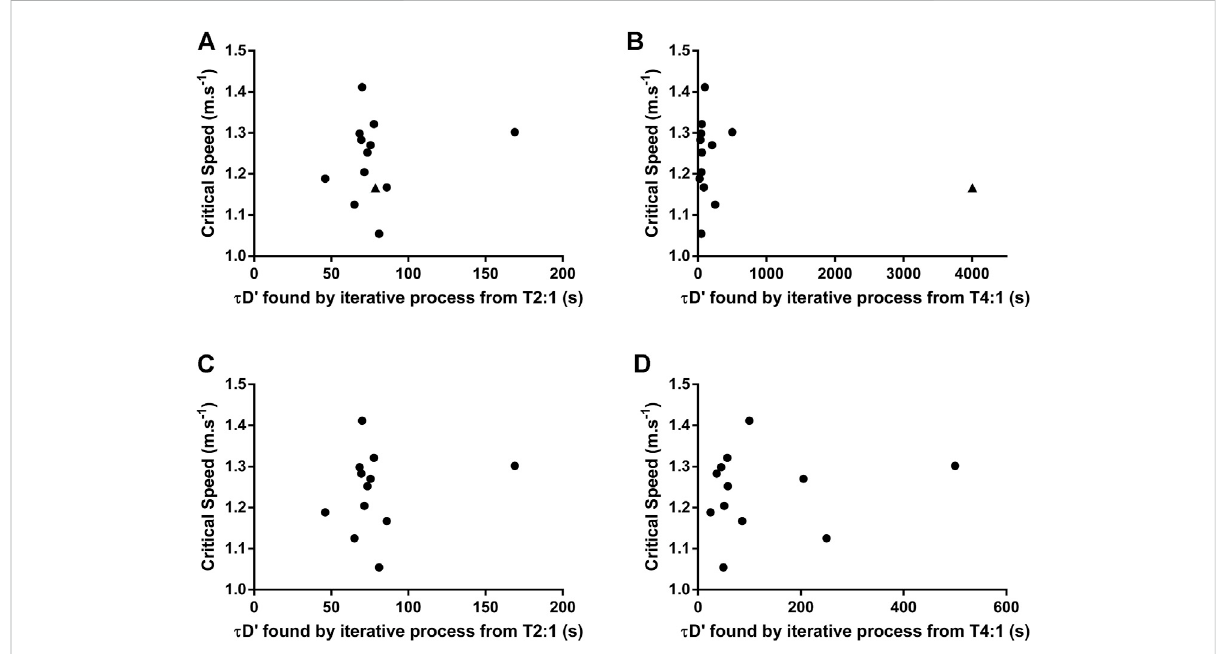
Relationship between Critical Speed and τ D ′ found by iterative process from training sessions with a work/relief ratio of 2:1 (T2:1) or 4:1 (T4:1). (A) and (B) show data analysis with all swimmers included. (C) and (D) show data analysis excluding the swimmer 11 (see results session for further details). ▲ represents the swimmer